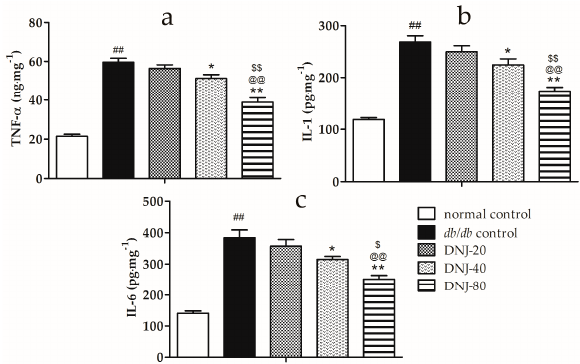
Figure 5. Effects of DNJ on the expression of tumor necrosis factor α (TNF- α ) ( a ); interleukin-1 (IL-1) ( b ); and interleukin-6 (IL-6) ( c ) in liver tissue of db / db mice. ## p < 0.01 vs. normal control. * p < 0.05, ** p < 0.01 vs. db/db control, @@ p < 0.01 vs. DNJ-20, $ p < 0.05, $$ p < 0.01 vs. DNJ-40 ( n = 6).